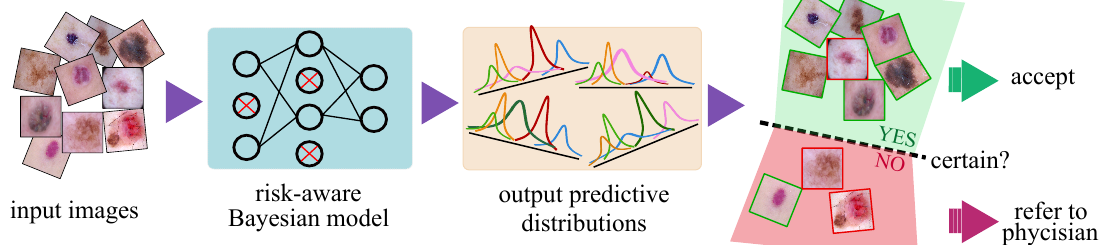
Figure 1. Processing pipeline of the proposed risk-aware Bayesian model. The Bayesian model outputs one predictive distribution per class (instead of the scalar outputs of the standard networks) whose mean and dispersion represents the network prediction and uncertainty, respectively. In the far right panel, the green (red) borders of the images illustrate the correct (incorrect) predictions of the automated model which is not always available as it requires manual annotation of samples by medical experts. The green (red) shaded areas, in contrast, depicts the regions where the model is certain (uncertain) about its prediction. Uncertainty is the natural output of the Bayesian model which serves as complementary information to refer the uncertain samples to experts and improve the overall prediction performance of the automated